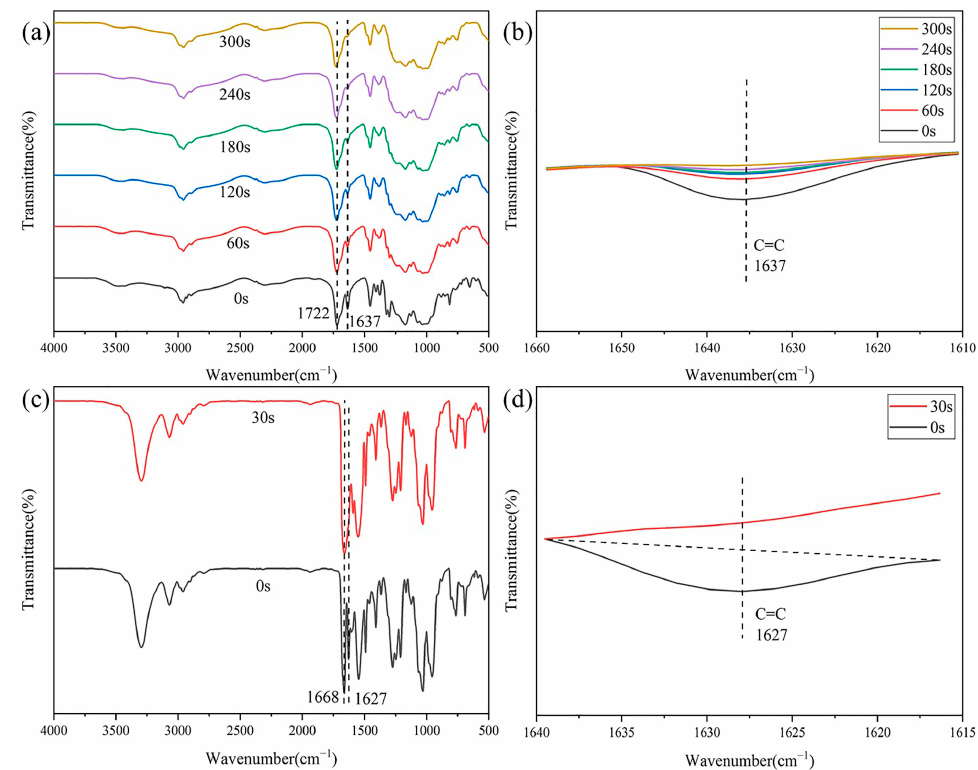
Figure 4. Real-time FTIR of the FNFs-1 and FNFs-5 coatings before and after curing: the full range ( a ) and local ( b ) spectrum of the FNFs-1 coating; the full range ( c ) and local ( d ) spectrum of the FNFs-5 coating.